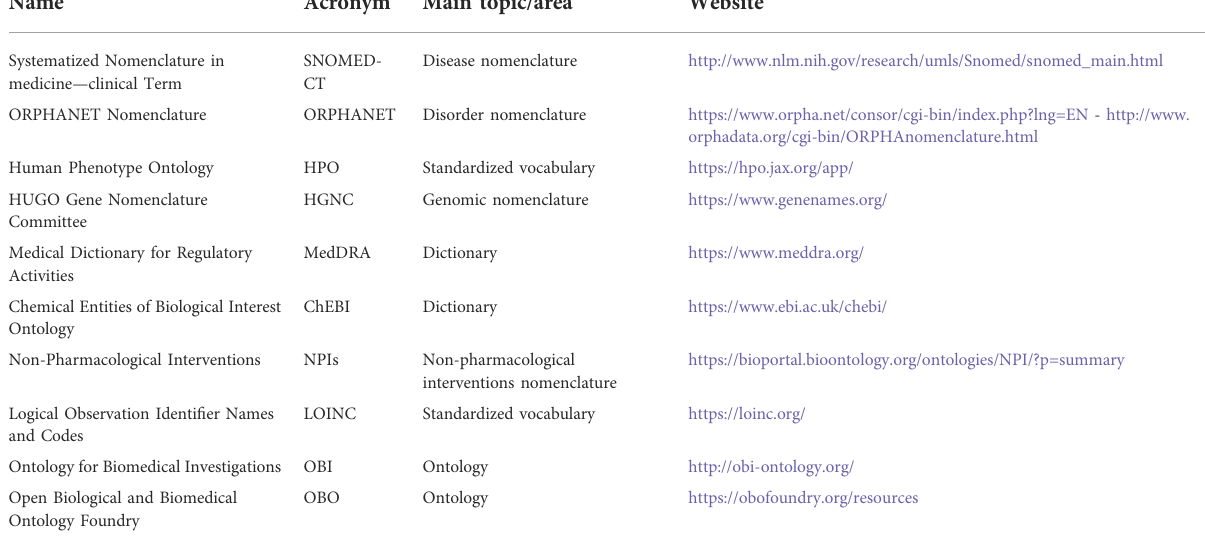
TABLE 1 Selected standards used in the REM